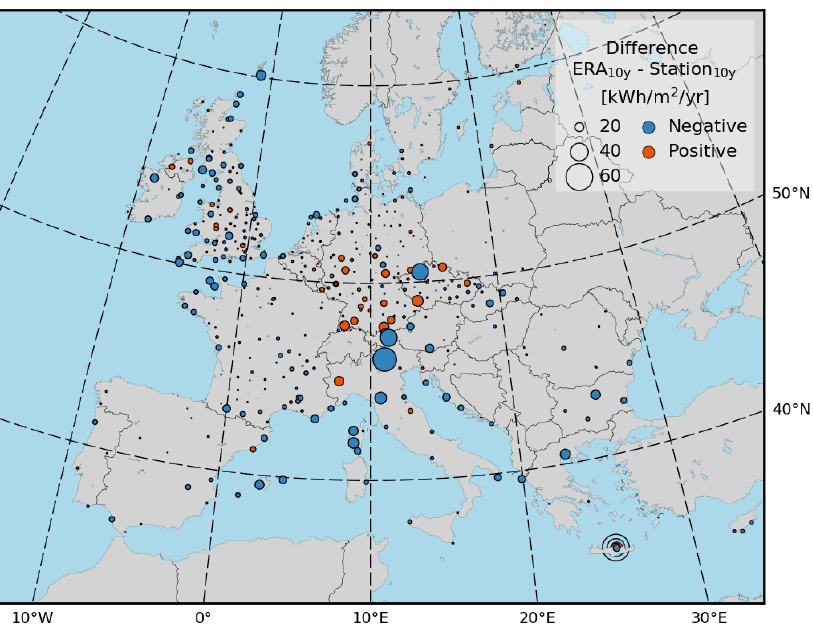
Figure 4. Map showing difference in EnergyPlus calculation for heating energy calculation when using the full 10-year ERA-interim data instead of the 10-year station data. Values are shown as kWh/m 2 difference, with the size of the marker indicating the magnitude of the difference. This calculation is for the single-family house configuration.